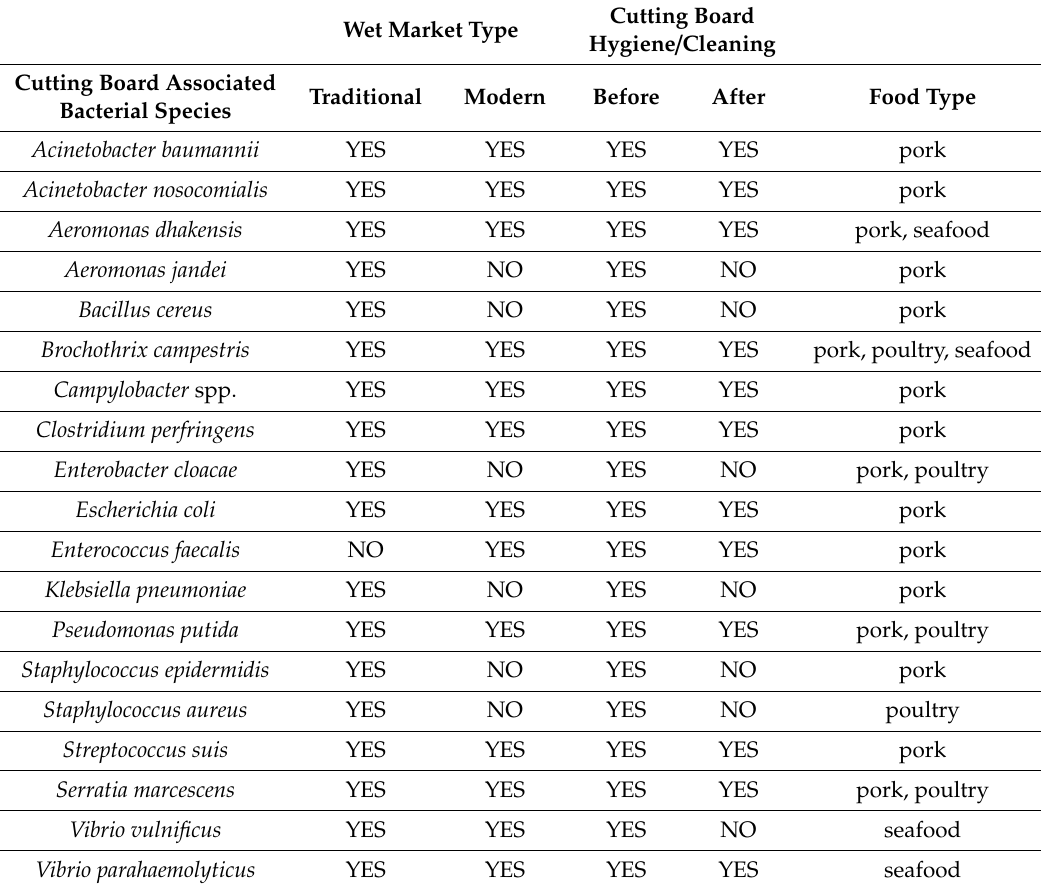
Table 1. Bacterial species on wooden cutting board surfaces in Hong Kong wet